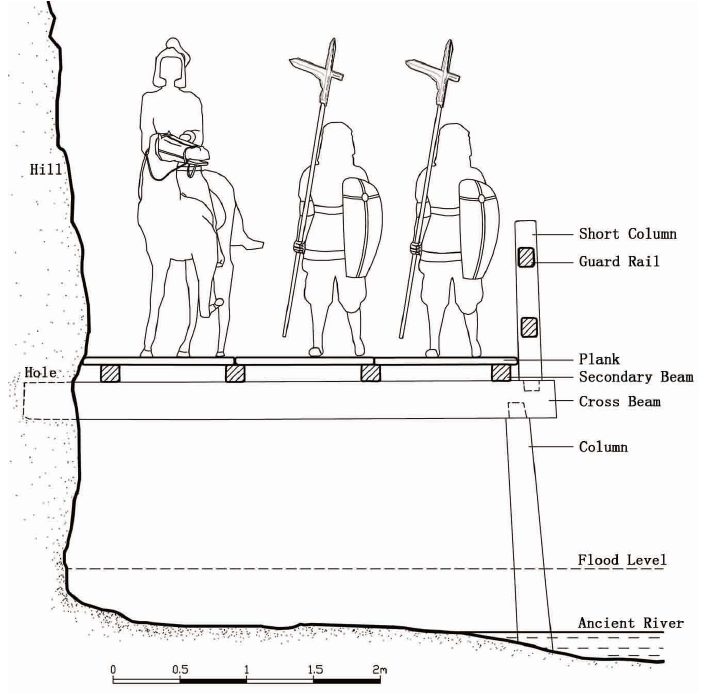
Figure 16. Viewing of the sectional restoration of the Chiya Plank